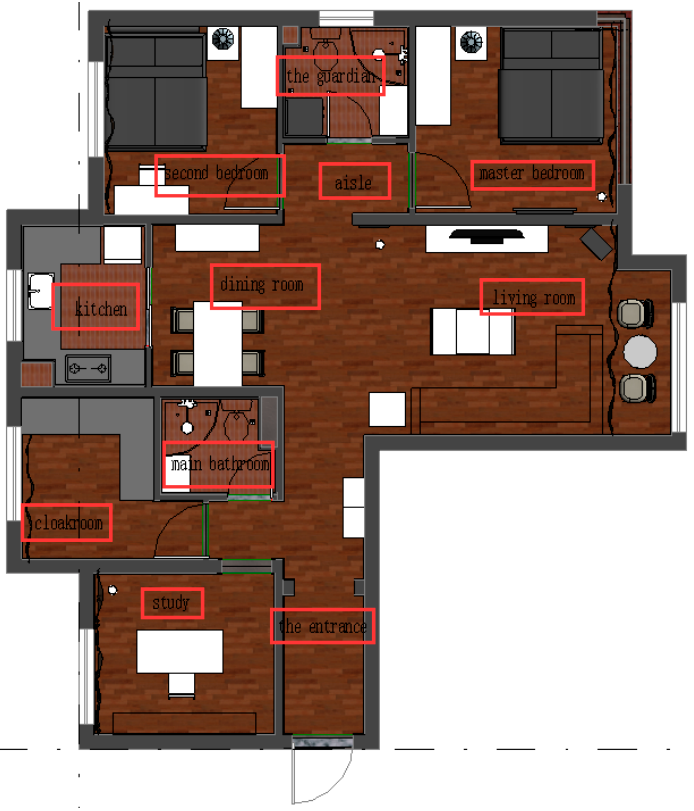
Figure 6. The BIM plan layout of the apartment as a case study in Xuzhou, China. The results can also be verified through the window list generated by Revit software (Figure 9): all windows of the case project are made of aluminum alloy glass, and the heat transfer coefficient is more than 2.0 W/(m 2 · k). Therefore, it is determined that the external window heat transfer coefficient does not meet the standard requirements. Hence, the value is set to